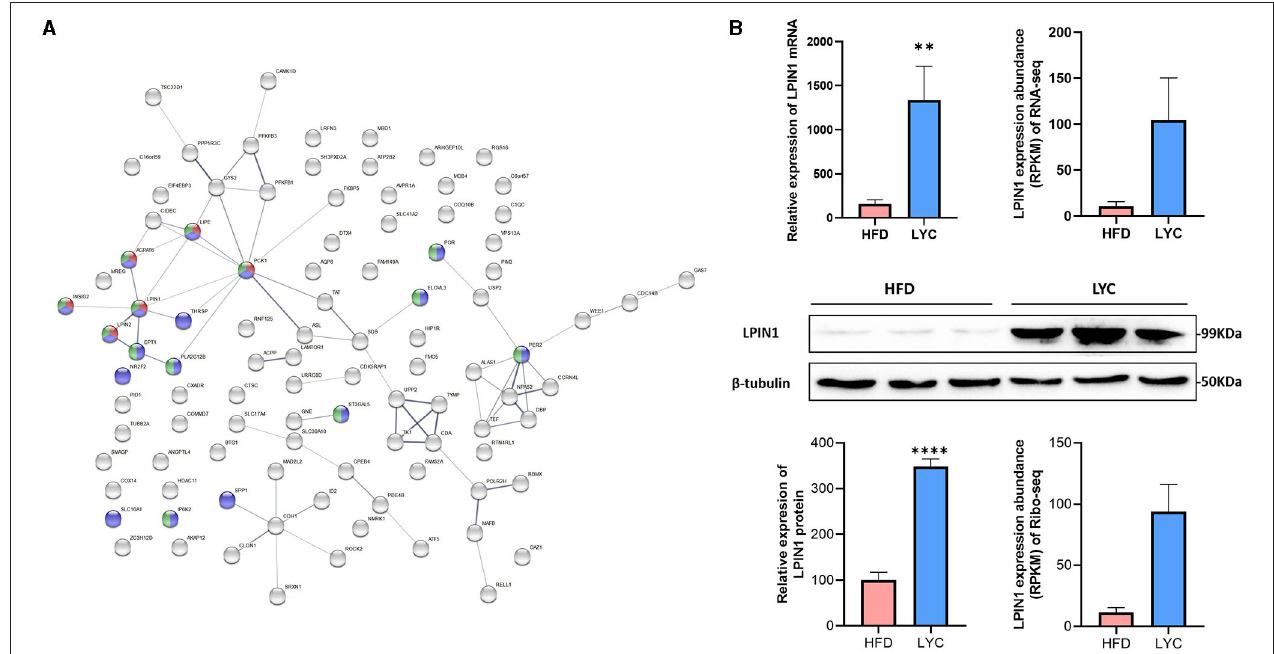
FIGURE 6 | Protein–Protein Interaction Networks. (A) Interactive map encoded by differential genes. Nodes represent the proteins. Red: TG metabolic process; Green: lipid metabolic process; purple: cellular lipid metabolic process. (B) LPIN1 expression level base on RT-qPCR, western blot, RNA-seq and Ribo-seq data. ** p < 0.01. **** p <